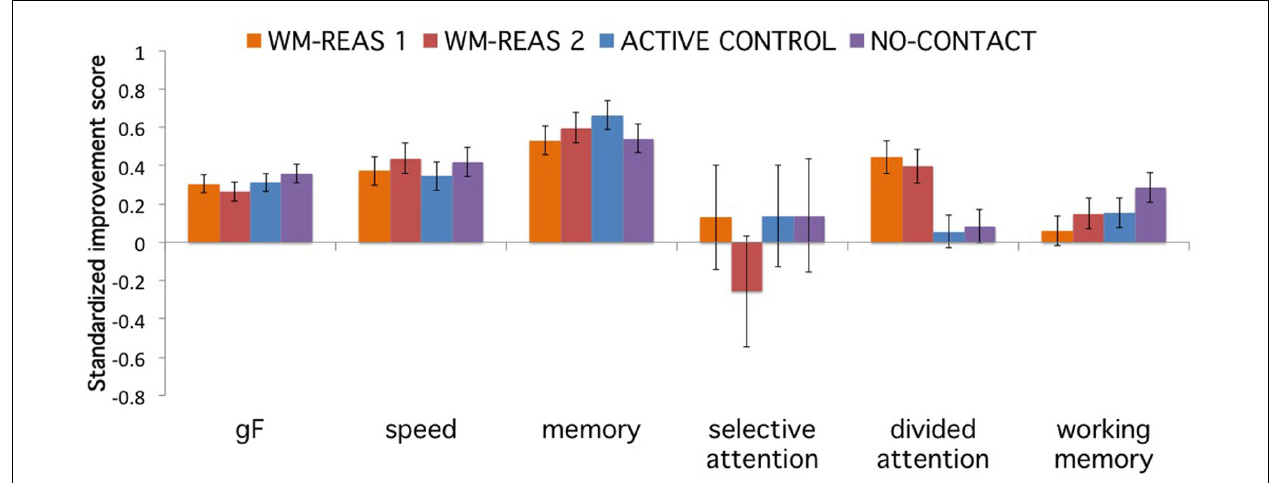
FIGURE 3 |Transfer gain as a function of composite and group. Error bars represent ± SEM.